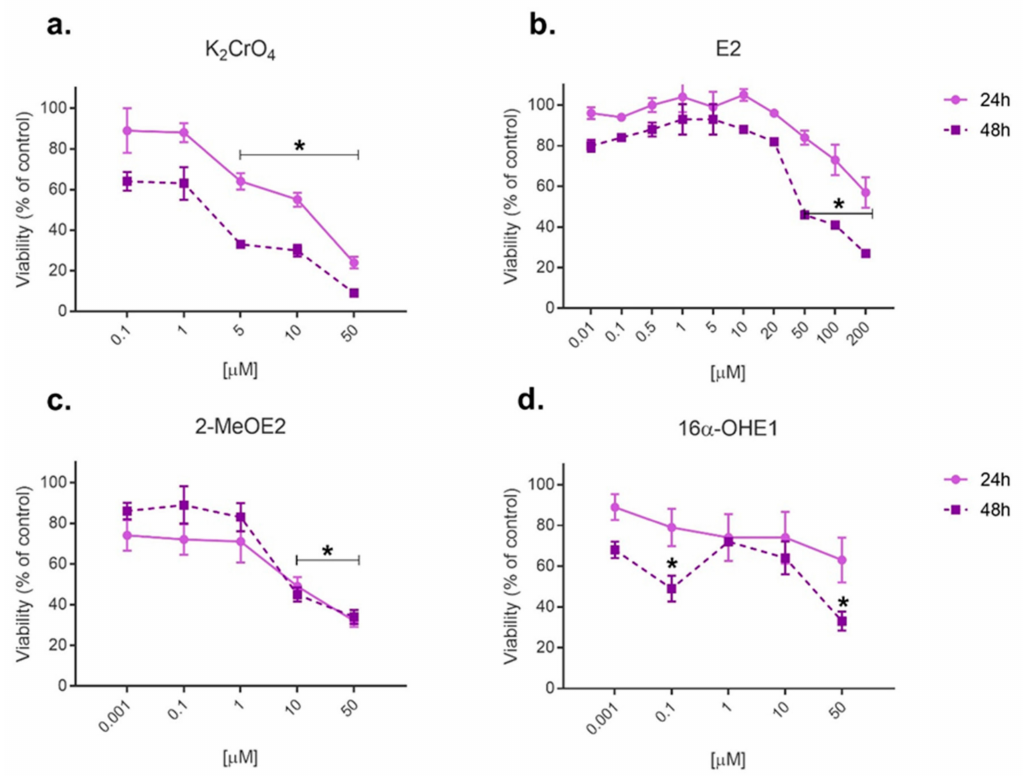
Figure 1. Changes in SKOV-3 viability after exposure to ( a ) K 2 CrO 4 , ( b ) 17 β -estradiol (E2), ( c )2-methoxyestradiol(2-MeOE2)and( d )16 α -hydroxyestrone(16 α -OHE1), measuredbyMTT,after24h and 48 h (* statistically significant, p <